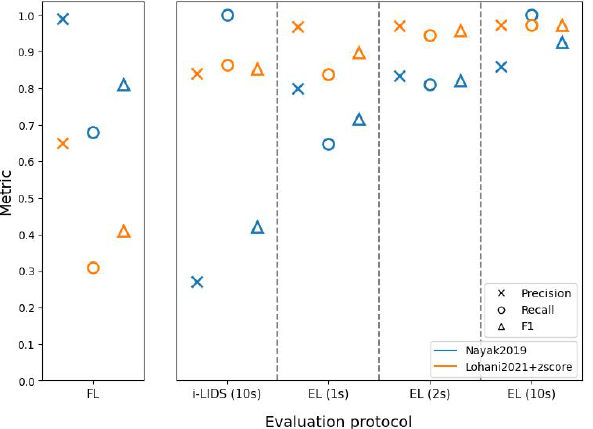
Figure 11. The results of two methods: Nayak et al. [47] (in blue) and Lohani et al. [6] with z-score (in orange), tested on view 1 of i-LIDS test set with intruder at close distance from camera. The abscissa represents three evaluation protocols: frame-level (FL) (on left subfigure), i-LIDS and edge-level (EL) (on right subfigure). i-LIDS is evaluated by default for 10 s whereas, for EL, we show results for 1, 2 and 10 s. The ordinate represents values of three metrics: precision, recall and F 1